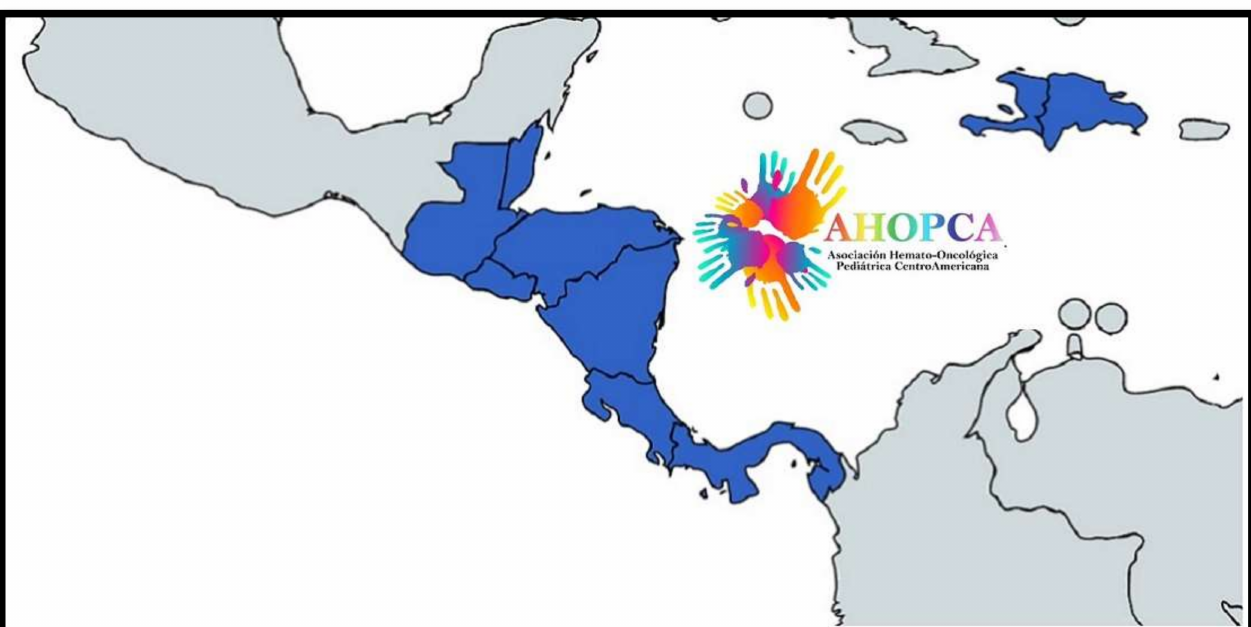
Figure 1. Countries included in